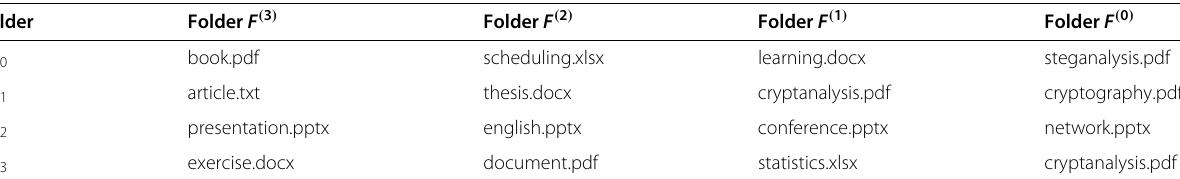
Table 4 Set of files distributed by folder in the cloud environment OneDrive